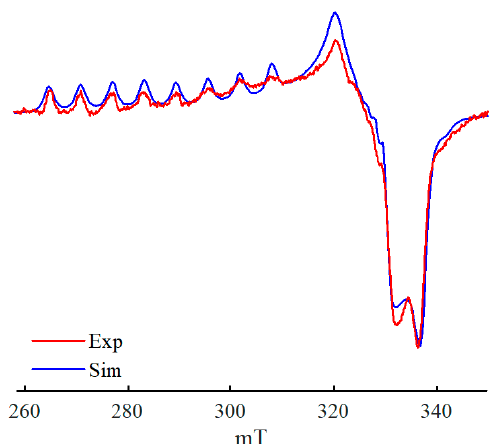
Figure 10. Real (red line) and simulated (blue line) EPR spectra of the catalytic system formed in toluene and in an argon atmosphere on the base of AlEt 3 and Co(acac) 2 · 3.0H 2 O, recorded at T = 77 K.